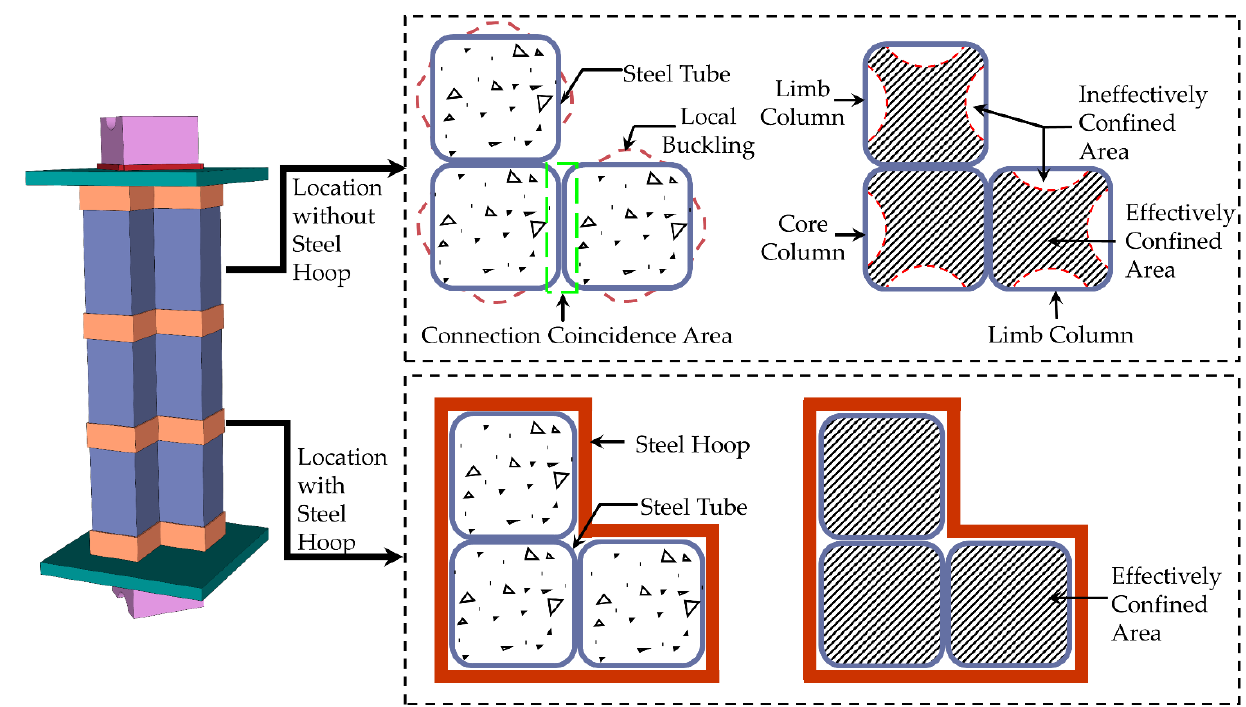
( b ) Figure 16. ( a ) Buckling characteristics of square steel tube under axial load; ( b ) effectively confined concrete in a square column. At the same time, the above test phenomena revealed that the local bulge deformation of the specimen occurred mainly on the outside of the shaped steel tube. In